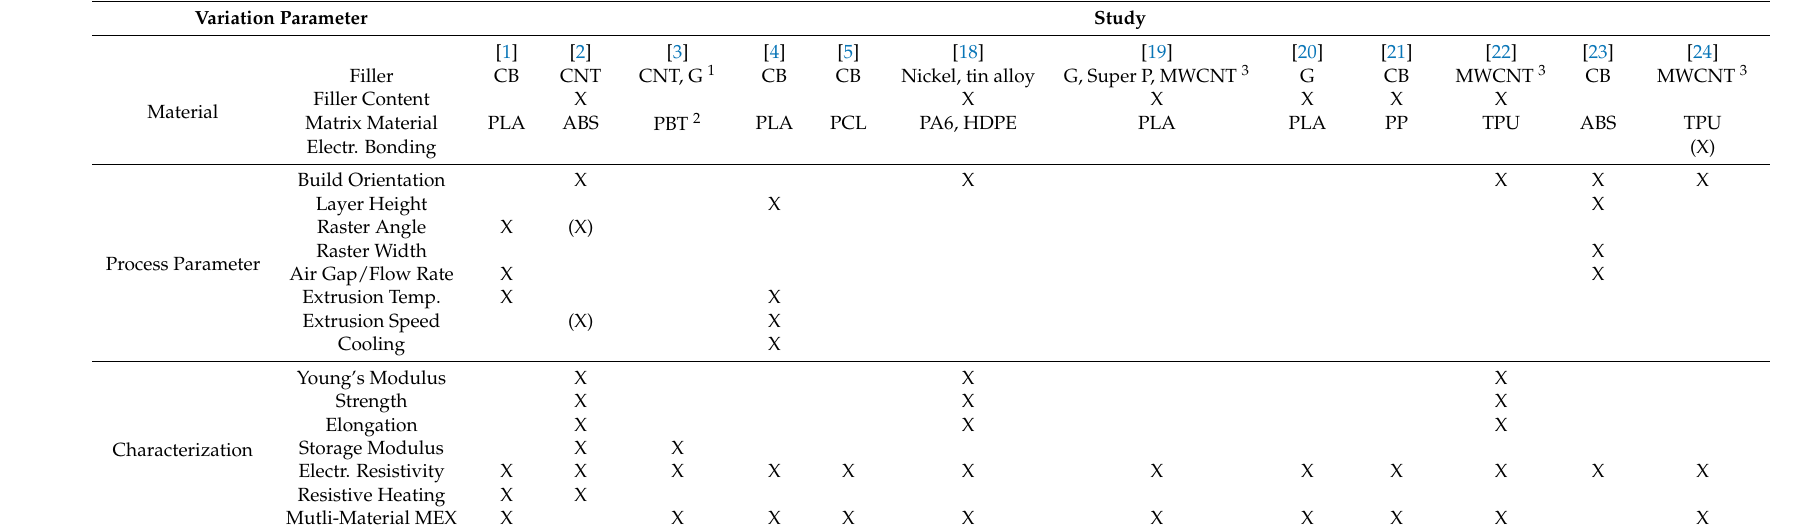
Table 1. Studies on electrical conductivity manufactured by material